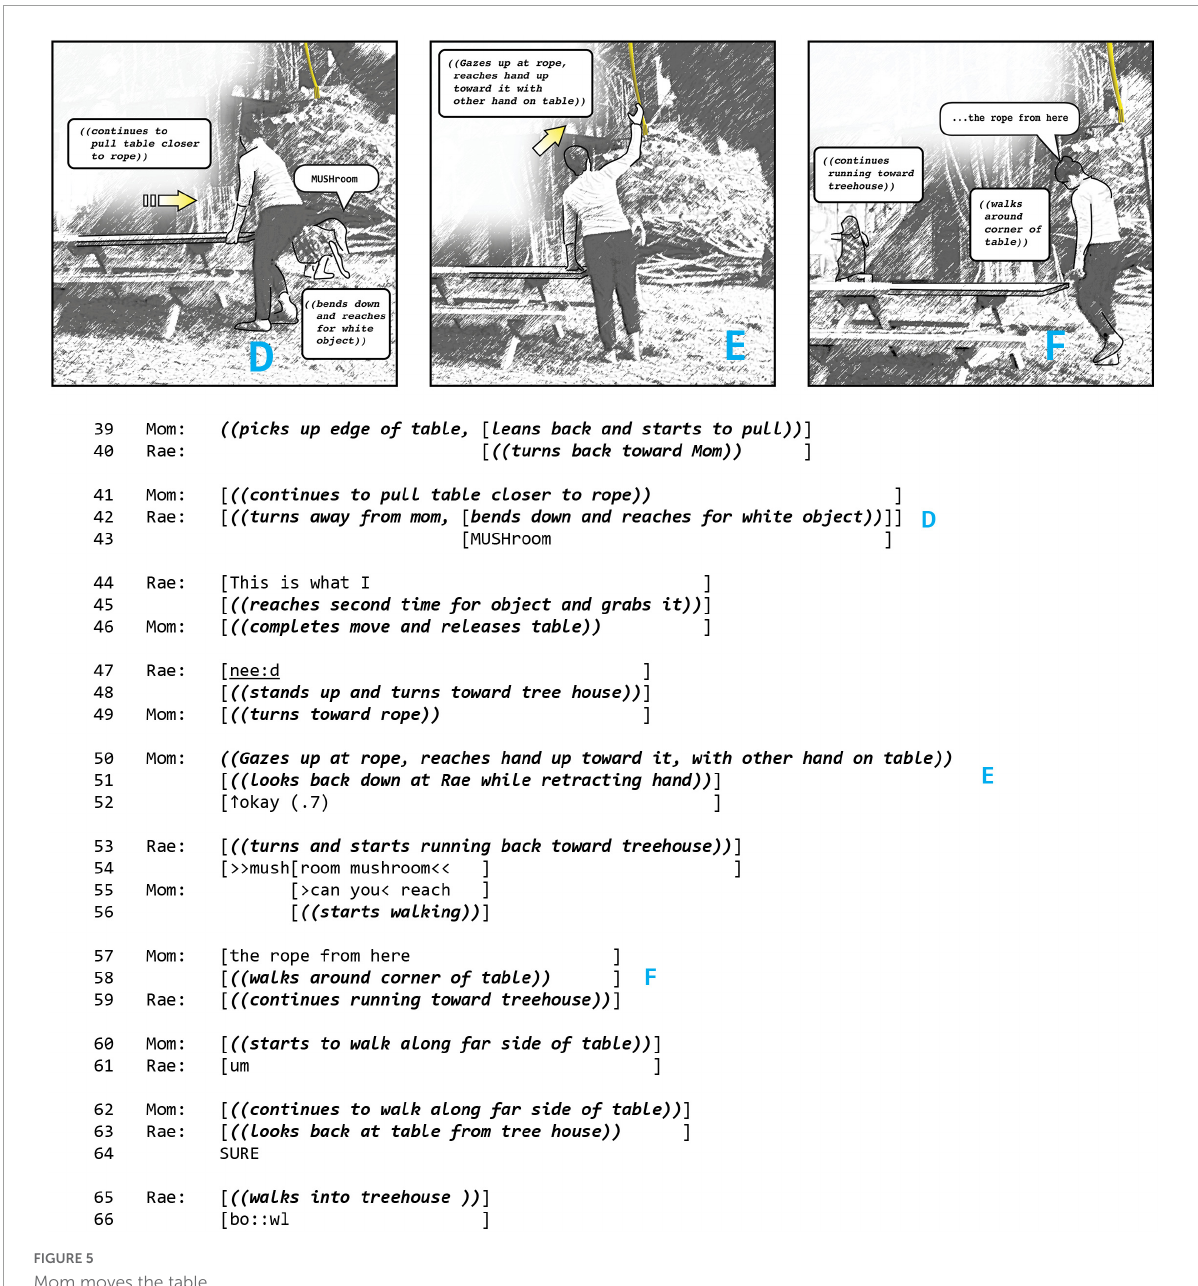
FIGURE5 Mom moves the